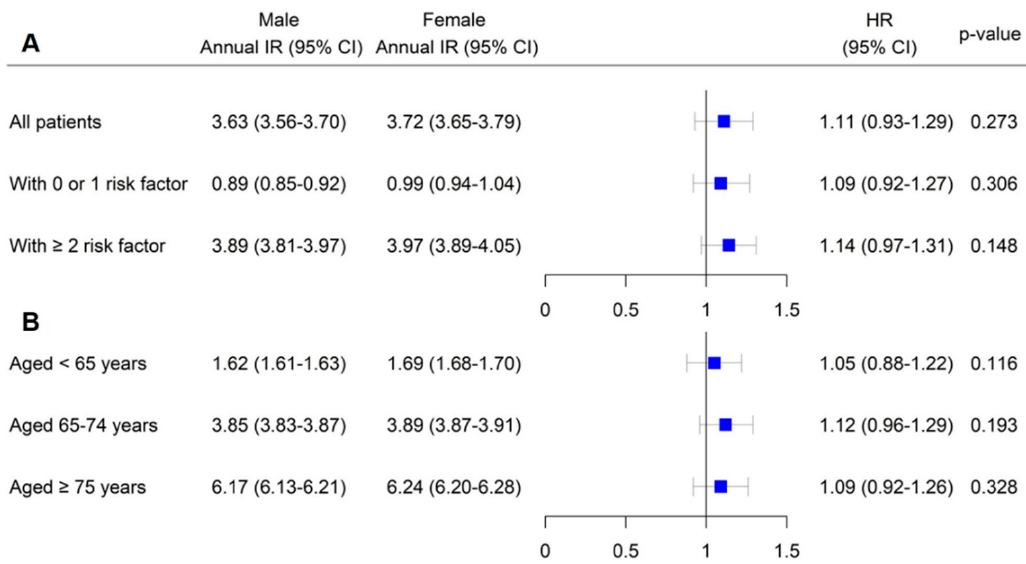
Figure 1. The risk of ischemic stroke for male and female patients stratified by risk factor components ( A ) and age groups ( B ). Hazard ratio of female to male patients in the incidence of ischemic stroke. CI, confidence intervals; HR, hazard ratio; IR, incidence rate (events divided by 100 person/year,